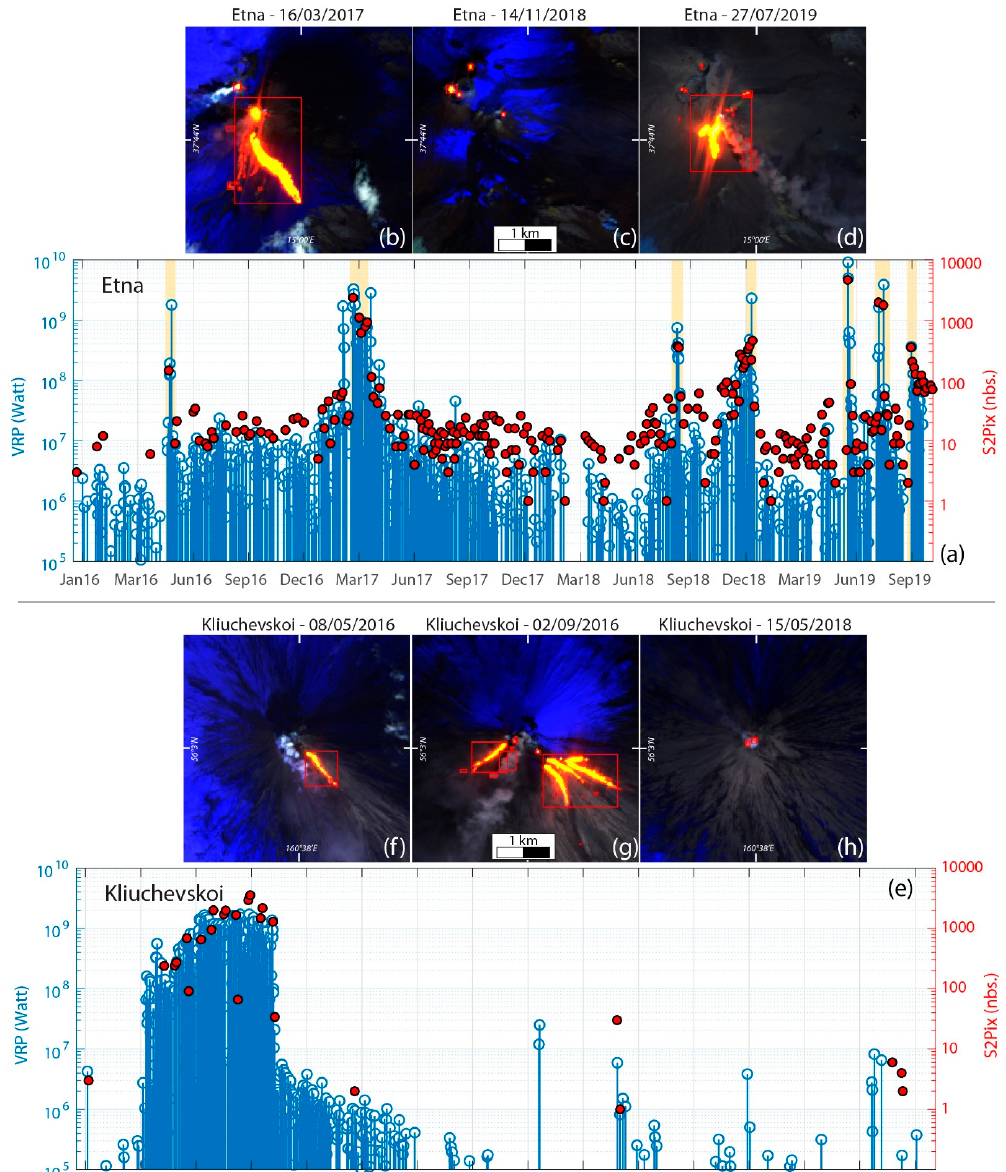
Figure 8. S2Pix and VRP–MIROVA thermal comparison on Etna and Kliuchevskoi lava-flow-type case studies. In ( a , e ), y-logarithmic timeseries. With blue stem on left y-axis, MIROVA VRP heat flux in Watt, with red dots on right y-axis the S2Pix. With yellow pale fields, major effusive phases are indicated for Etna case. In ( b – d ), images, particulars of thermal emissions and volcanic activity over Etna summit. In ( f – h ), particulars of thermal emissions and lava flows over Kliuchevskoi summit area.